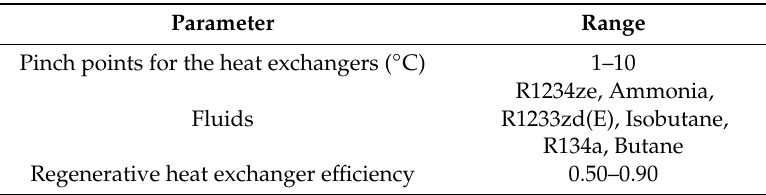
Table 5. Operating conditions used for the thermo-economic analysis.